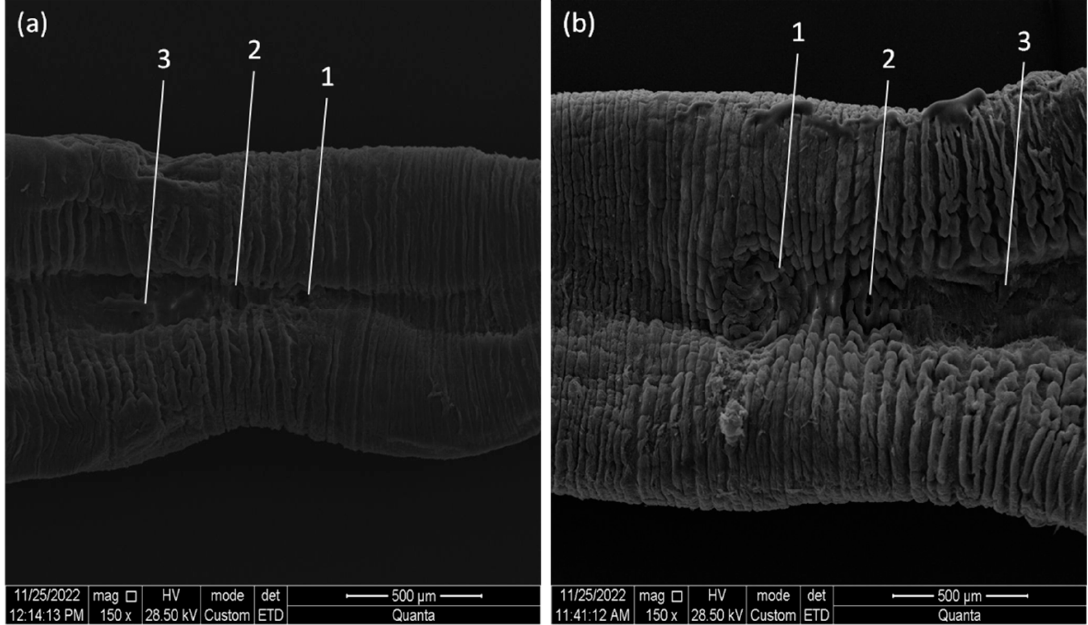
Figure 6. External organs of the Piscicola sibirica sp. nov. reproductive system: ( a ) specimen from the Bratsk reservoir (voucher BS31) and ( b ) specimen from the Irkutsk reservoir (voucher M28). Numerical designations: 1—male gonopore, 2—female gonopore and 3—external copulatory